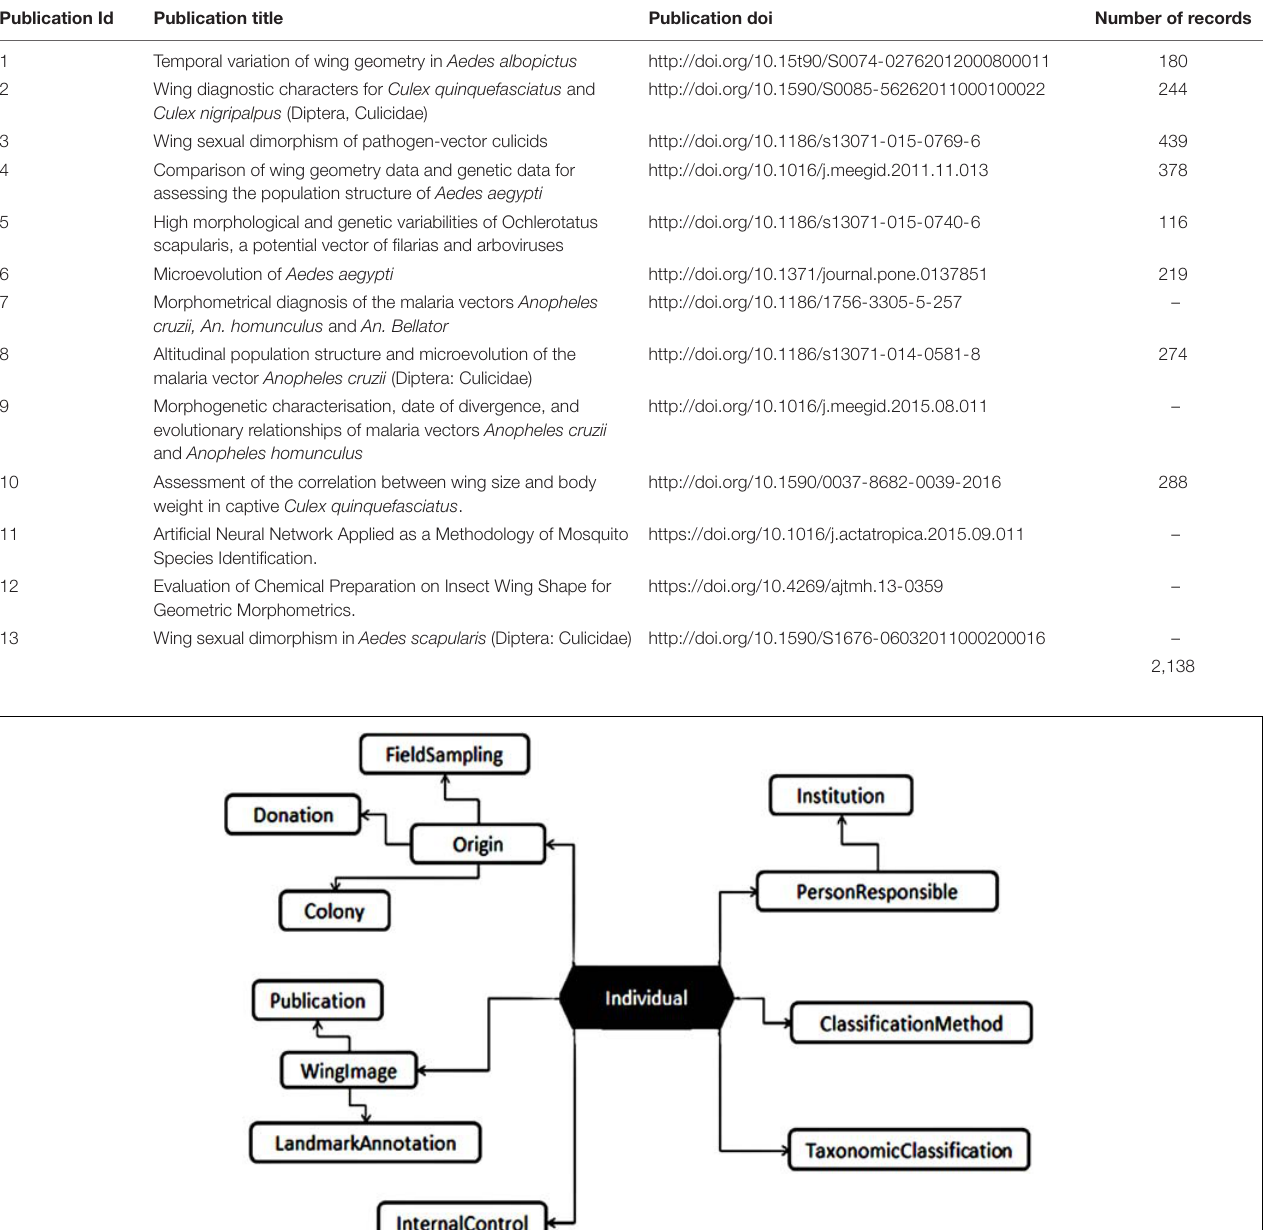
TABLE 1 | List of publications and data available on WingBank for use by third parties.